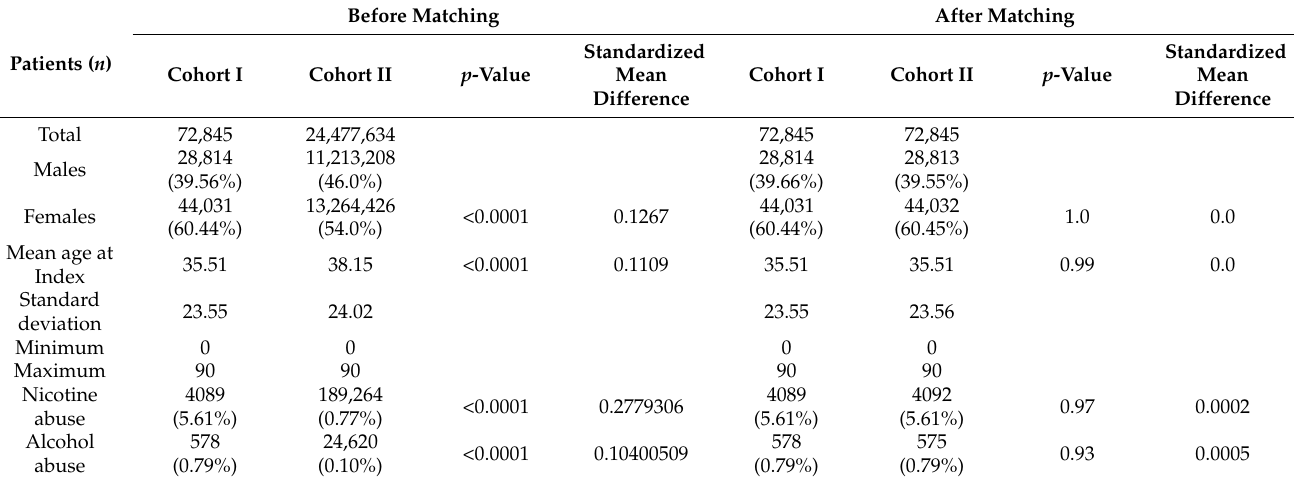
Table 1. Patient characteristics before and after matching of cohorts I (ICD-10 code K12) and II (without ICD-10 code